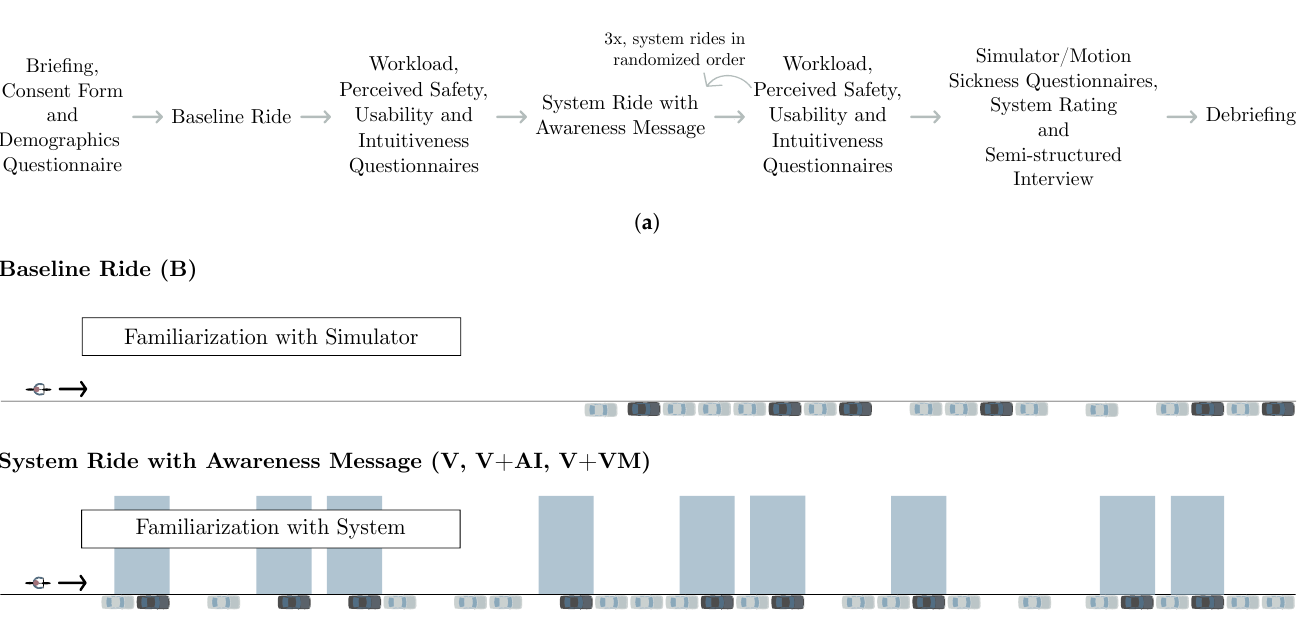
Figure 4. An overview of the study procedure ( a ) and a schematic representation of the rides ( b ). The car symbols represent parked vehicles, and the darker cars represent occupied vehicles. The gray areas illustrate an exemplary (not accurate) time period during which the AMs are presented. In each three subsequent occupied vehicles, each door opening type occurred once. Further, we highlighted that the first third of the baseline ride was reserved for familiarizing with the simulator. The first three notifications for occupied vehicles were intended for familiarization with the notification